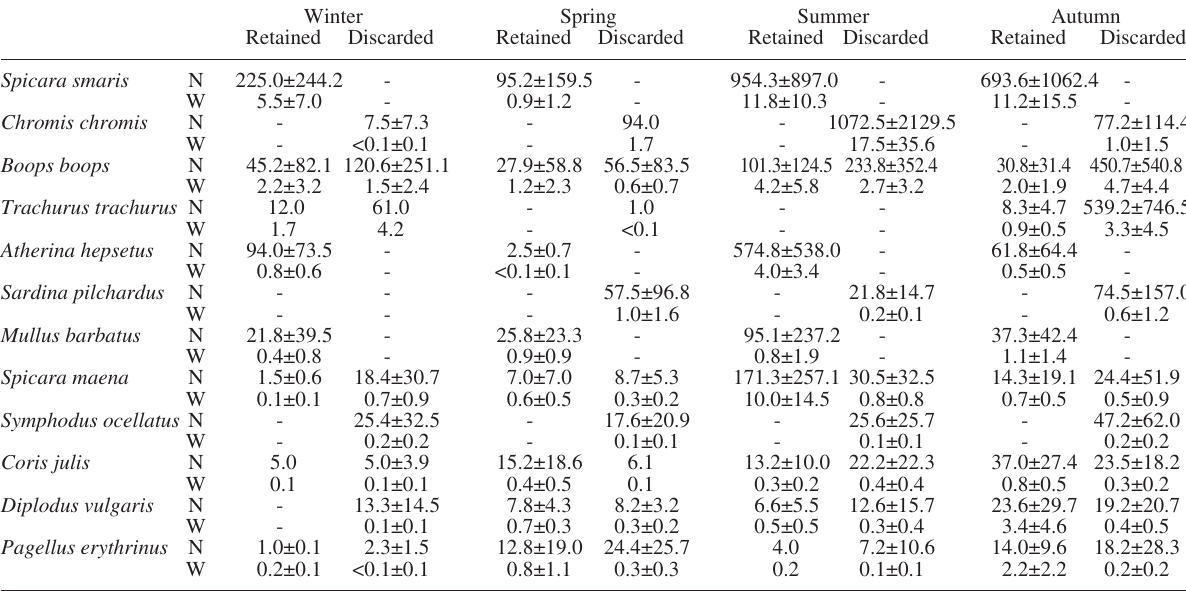
Table 3. – Mean (±SD) retained and discarded catch per haul in numbers (N) and weight (W) by season for the most abundant species in boat seine catches on Posidonia beds (eastern